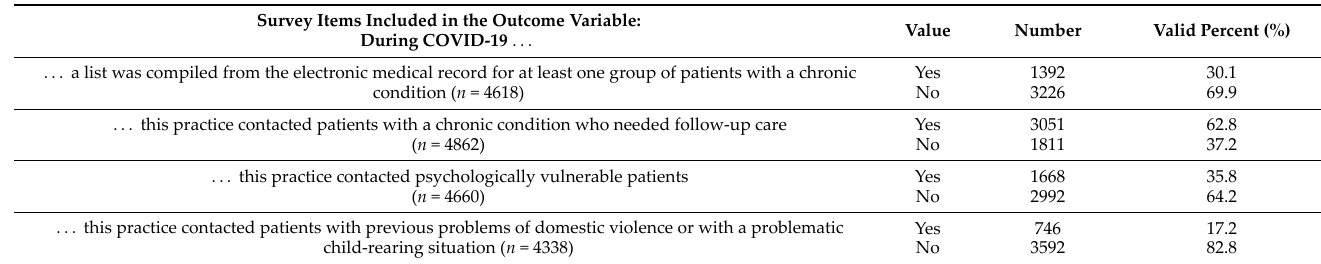
Table 1. A description of the survey items included in the outcome variable ( n = 4982). Survey Items Included in the Outcome Variable: During COVID‑19 ...